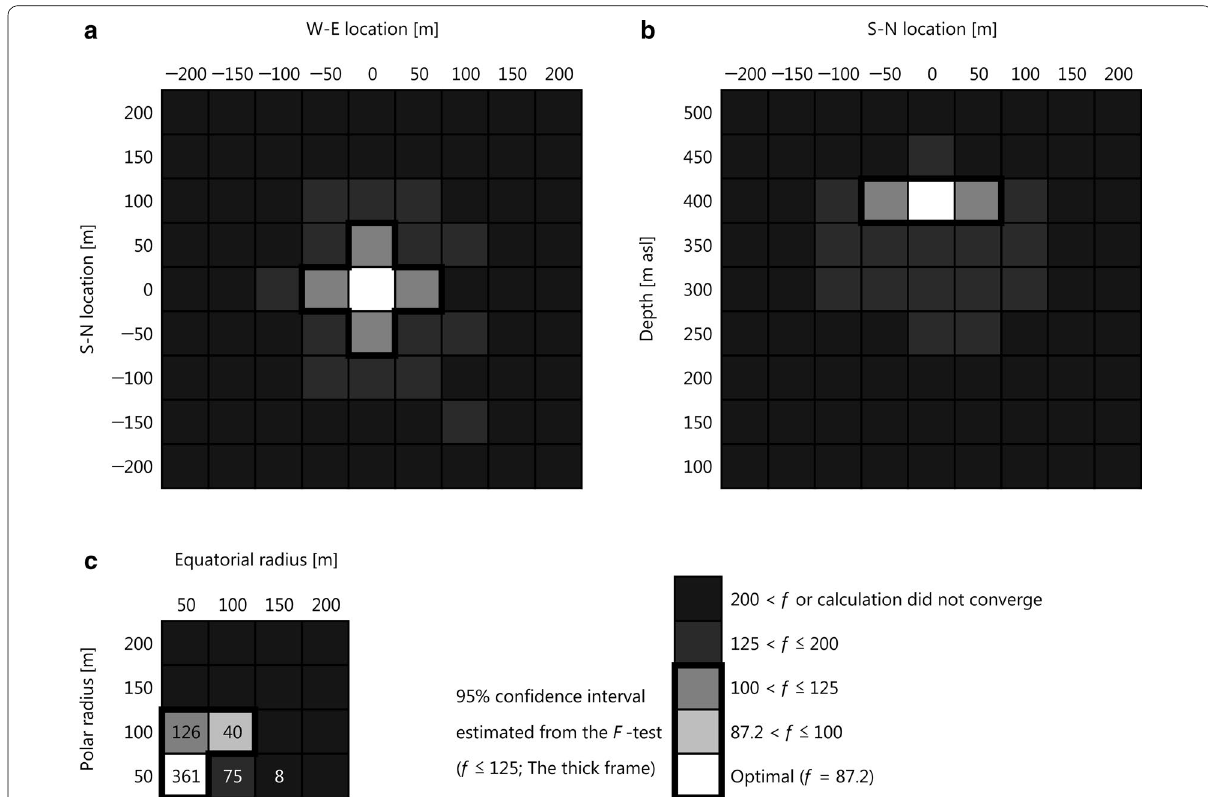
Fig. 8 a A grid map of the f value for the parameter spaces of horizontal locations. The thick frame indicates 95% confidence interval estimated from the F test (Árnadóttir and Segall 1994). b Same as a for the parameter spaces of S–N location and depth. c Same as a for the parameter spaces of equatorial and polar radii at each optimal pressure change. The number indicates optimal pressure increase in MPa, and calculation did not converge for the cells without